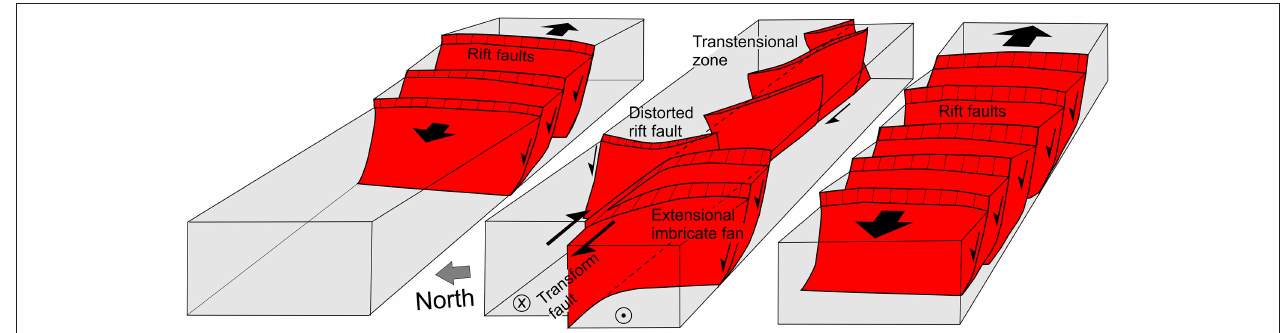
FIGURE 13 | The model of transform fault termination suggested by our data: The main transcurrent fault plane gradually bends and splays giving rise to a releasing imbricate fan. Further east, the fault interacts within the rift zone producing en-échelon fissures and normal faults rotated anticlockwise with respect to the N–S rift structures. The size of the half arrows (along the transform fault) is proportional to the amount of strike-slip motions; the size of the full arrows is proportional to the extension amount in the